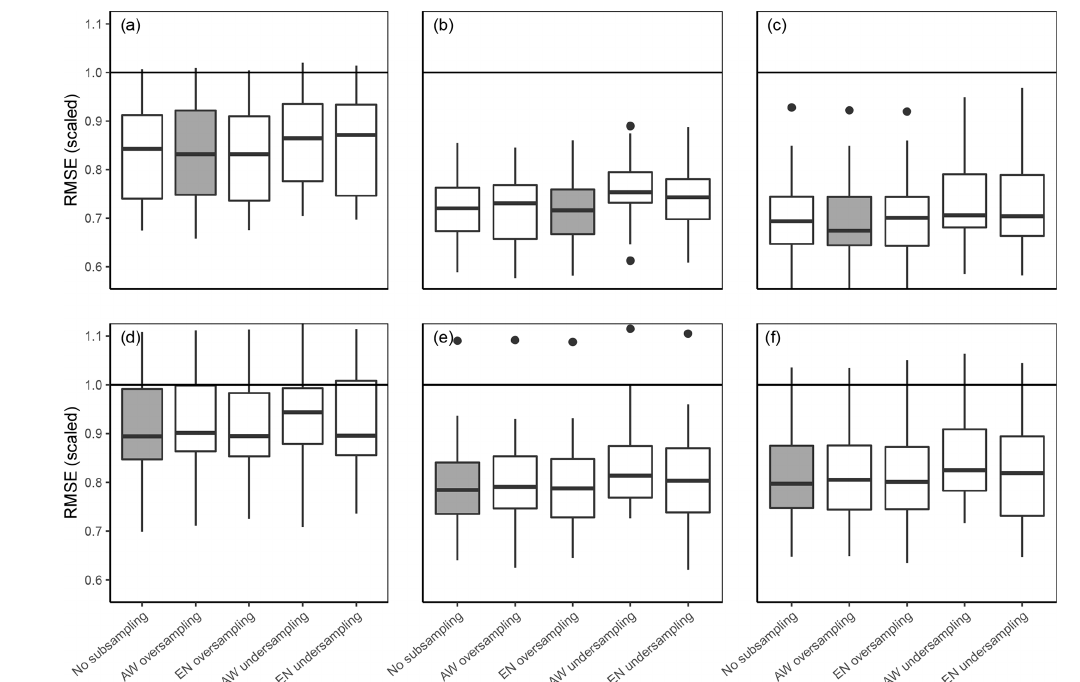
Figure 6. Model performance as boxplots of RMSEs of the five repetitions for three particle size contents for (a, d) clay, (b, e) silt, and (c, f) sand and five subsampling methods. The models (a) , (b) and (c) are for 10cm depth, while (d) , (e) , and (f) are 70cm depth. The subsampling method with the lowest median RMSE is highlighted. The black horizontal lines stand for an RMSE of one, which equals the RMSE of predicting the observed mean.